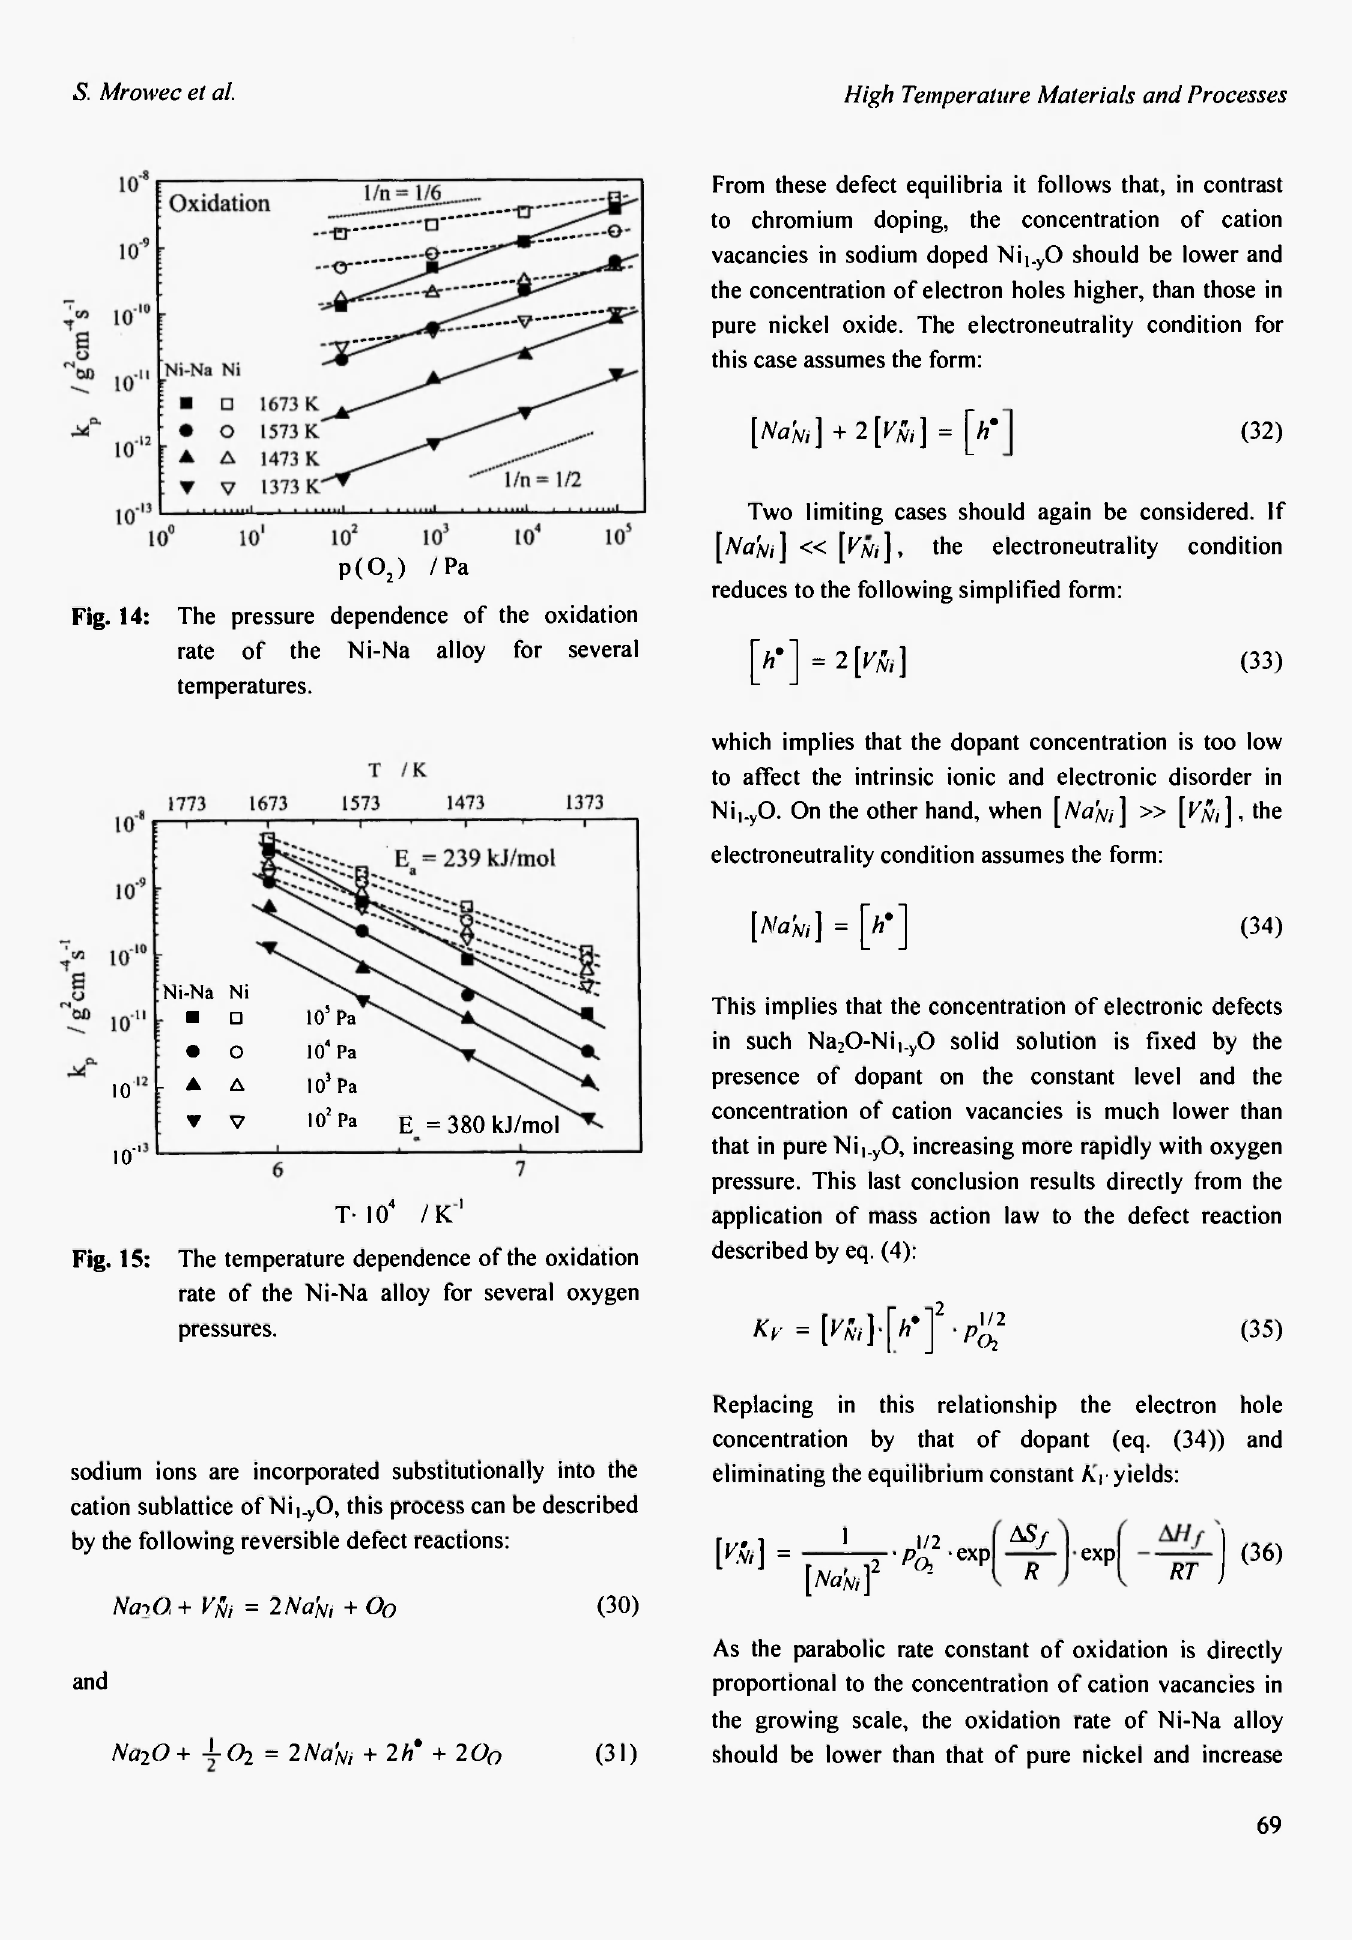
The temperature dependence of the oxidation rate of the Ni-Na alloy for several oxygen